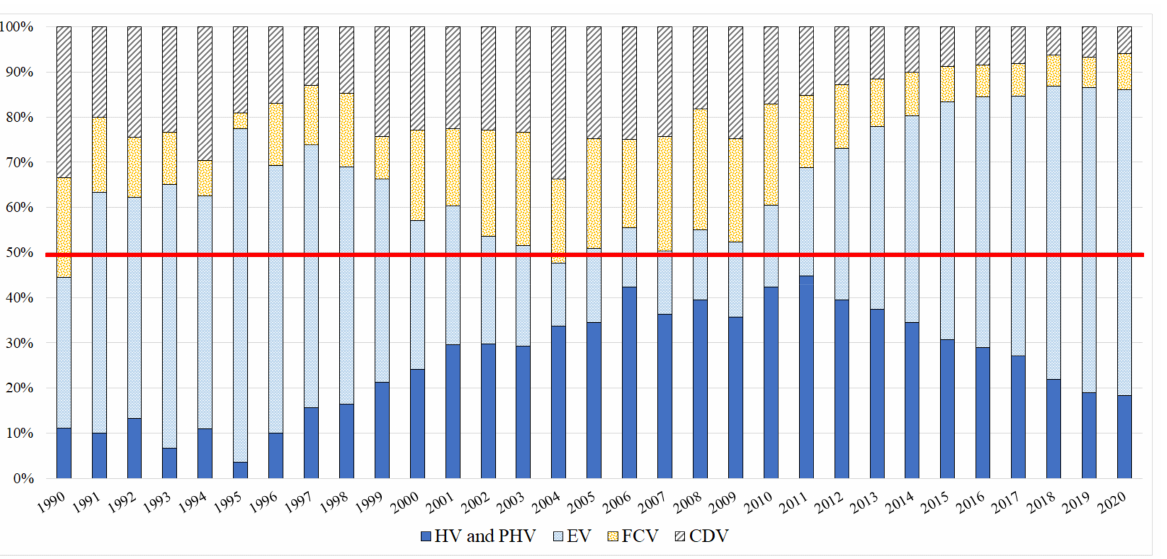
Figure 1. Number transition of research studies on each type of